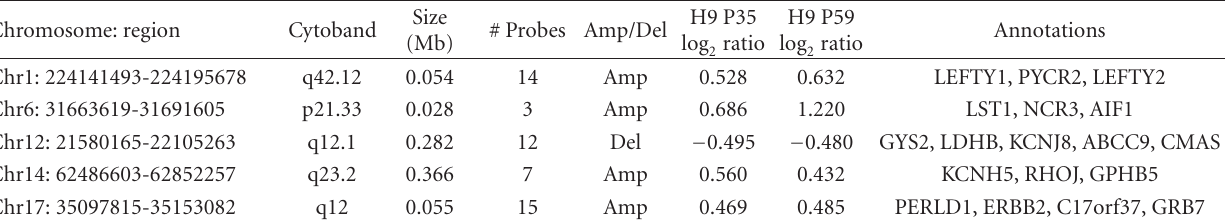
Table 1: Regions in H9 human ESCs with genomic abberations as determined by aCGH (corresponding schematic is shown in Figure 4(e)). No subkaryotypic alterations were detected in hESCs propagated for 24 consecutive passages (H9 P59) relative to the starting hESC population (H9 P35), suggesting that the genome of laser-mediated passaged cells is both normal and stable. Data is reported using genome ratios ≥ 0.6 are amplifications (amp) or ≤ − 1.0 are deletions (del) found in all cells. log built HG18. log 2 mosaicism within the